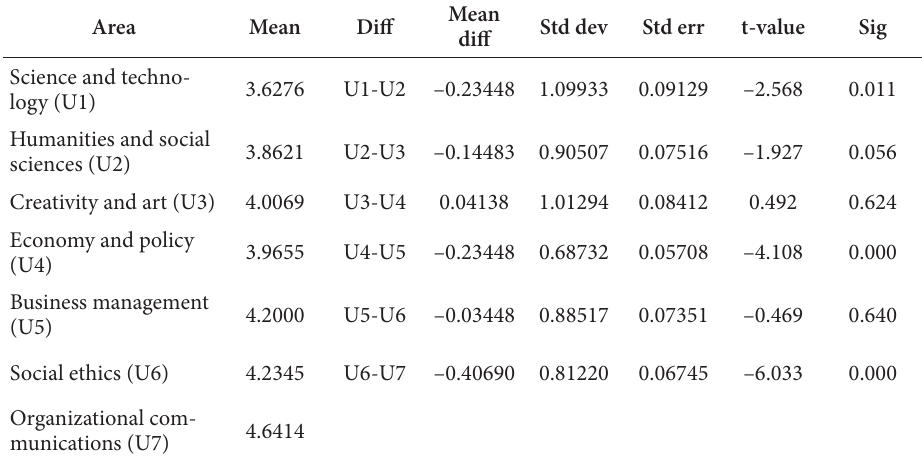
Table 7. Comparing the importance of seven knowledge areas for deciding on promotion